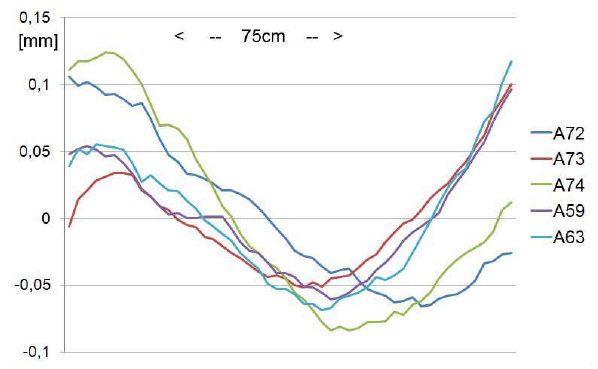
Figure 3. Sideline correction of backward looking camera